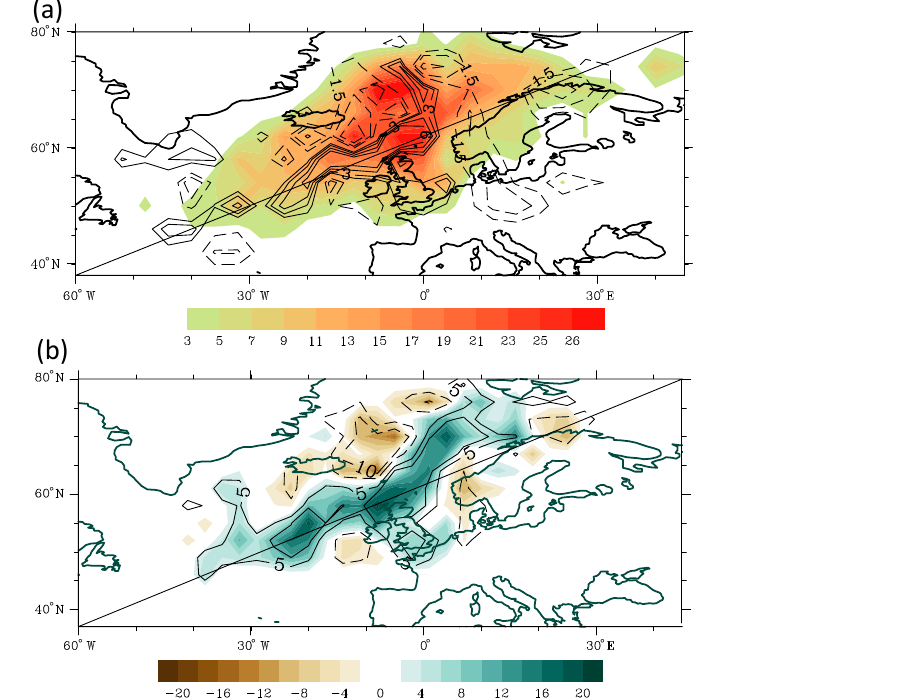
Figure 9. (a) Difference between + 2 minus + 1.5 ◦ C ensemble experiments (contour levels: − 4.5, − 3, − 1.5, 1.5, 3, 4.5, 6; contours for negative values are dashed) and mean climatology (shaded) in the years 1979–2005, derived for the number of 3h storm occurrences accu- mulated within 4 ◦ × 4 ◦ grid boxes (number/decade); climatology derived for the period 1979–2005 is shaded. The ensembles for + 2 and + 1.5 ◦ C constitute five decadal periods each; the 1979–2005 period is missing one year (1981). (b) Difference between + 2 minus + 1.5 ◦ C ensemble experiments, estimated for a number of 3h occurrences with a maximum larger than 0.25 (mmh − 1 ) and wind larger than 10ms − 1 (number/decade). Maximum values were chosen from 3h precipitation data at 0.25 ◦ , which falls into 3 ◦ × 3 ◦ grid boxes. Differences were computed for grid boxes with the number over the threshold of at least 20 per decade in both experiments. Contours for negative values are